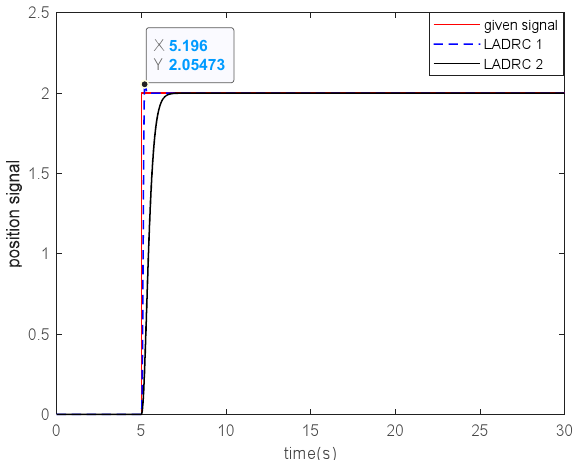
Figure 22. Step responses from the LADRC with ATD and LADRC without ATD.